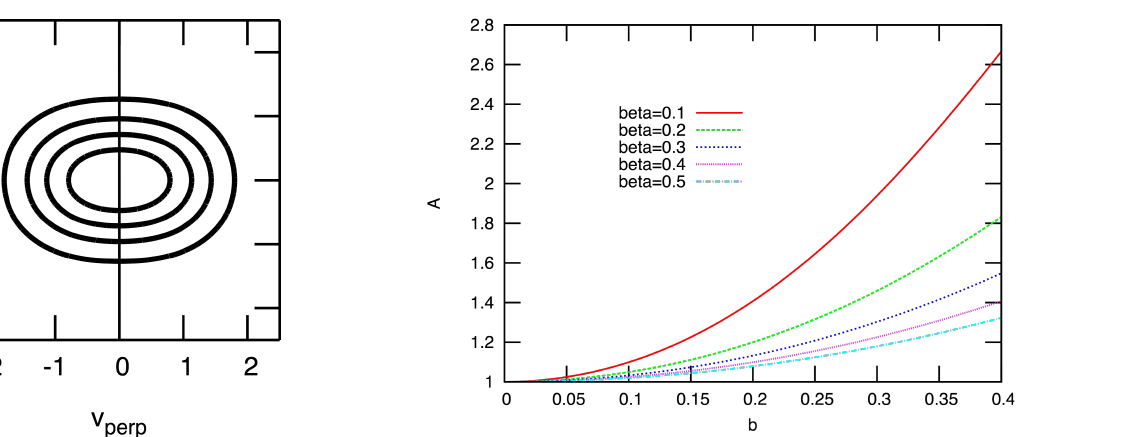
Fig. 1. Distribution function in the presence of a large-amplitude wave. The solid line represents the magnetic field direction. The velocities are given in units of the thermal speed. The broadening in the perpendicular direction is clearly visible.